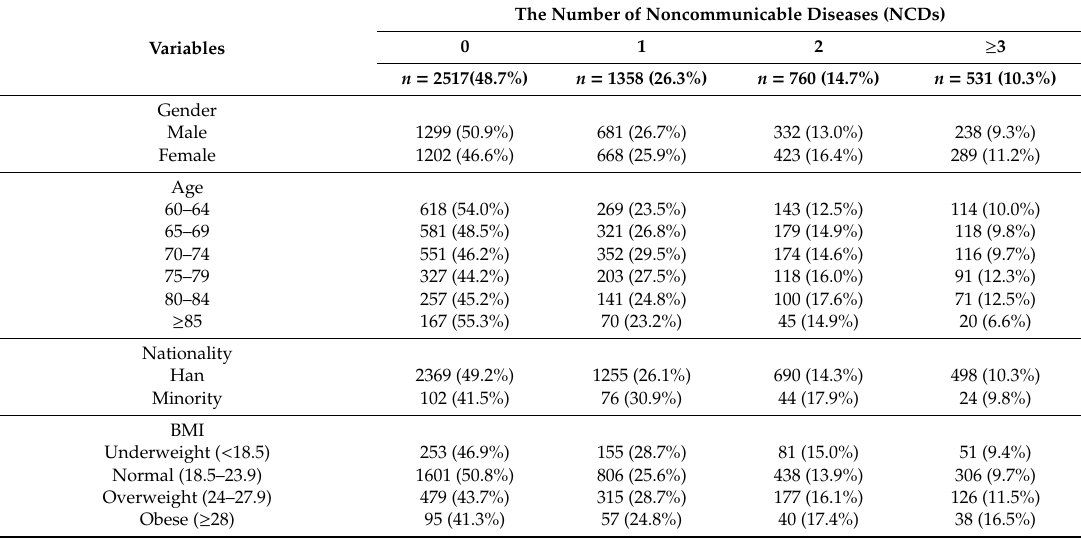
Table 1. The number of noncommunicable diseases (NCDs) in di ff erent demographic groups. The Number of Noncommunicable Diseases Variables